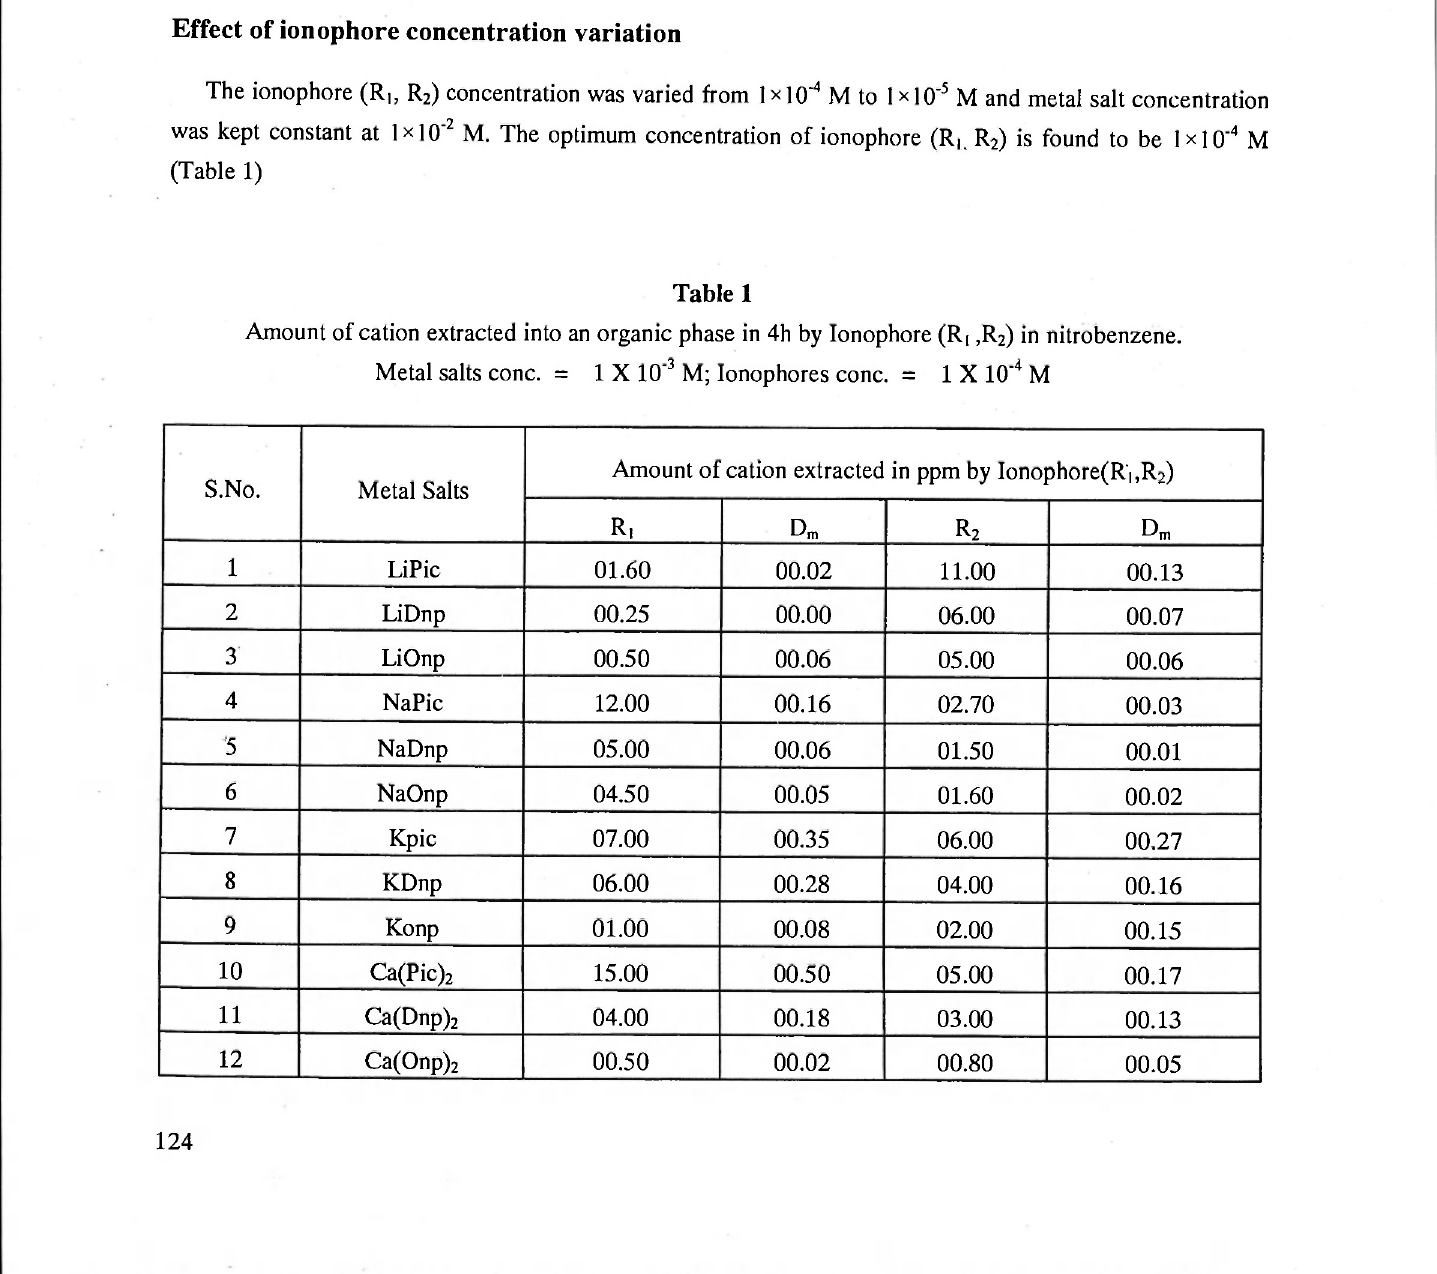
Amount of cation extracted into an organic phase in 4h by Ionophore (R, ,R 2 ) in nitrobenzene. Metal salts conc. = IX 10" 3 M; Ionophores conc.